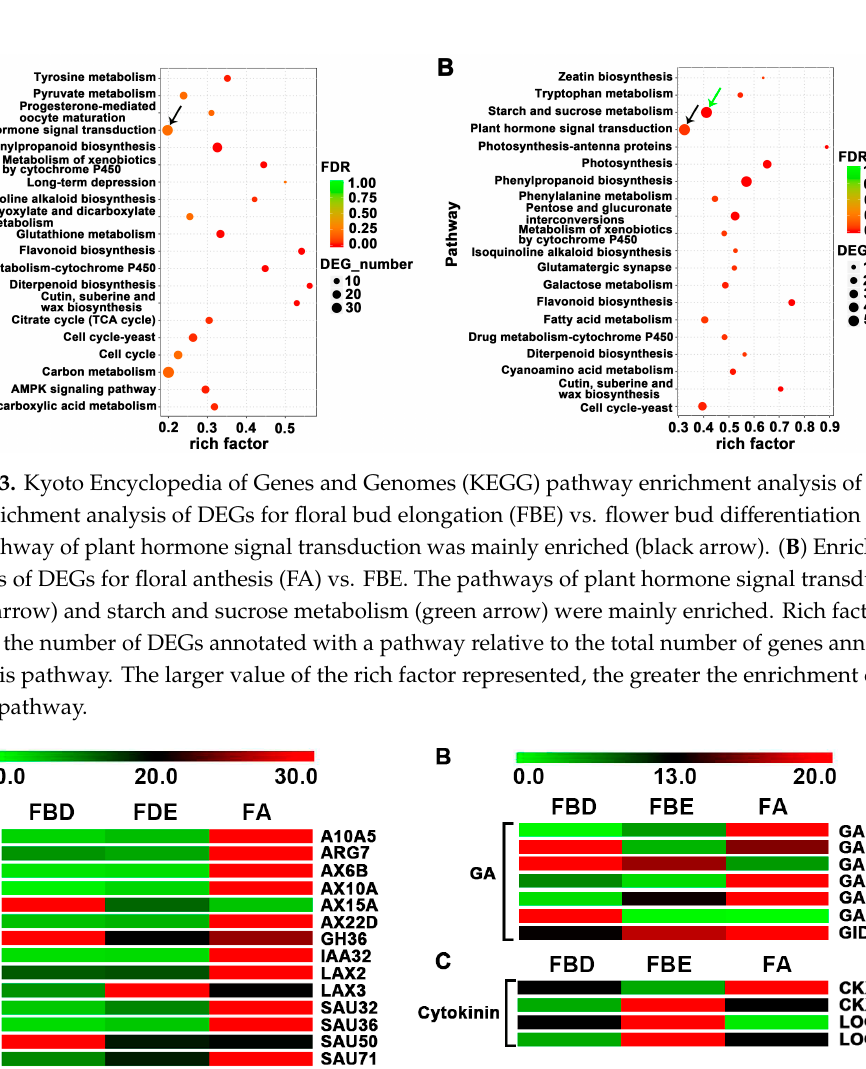
Figure 4. Expression level changes of the DEGs involved in the auxin, gibberellin (GA), and cytokinin signaling and metabolism pathways in three flower development stages in loquat. ( A ) Expression levels of DEGs of auxin signaling pathways. ( B ) Expression levels of DEGs of GA signaling and metabolism pathways. ( C ) Expression levels of DEGs of cytokinin signaling pathways. Table 1. Differentially expressed genes (DEGs) involved in the signaling pathways of auxin, GA, and cytokinin.